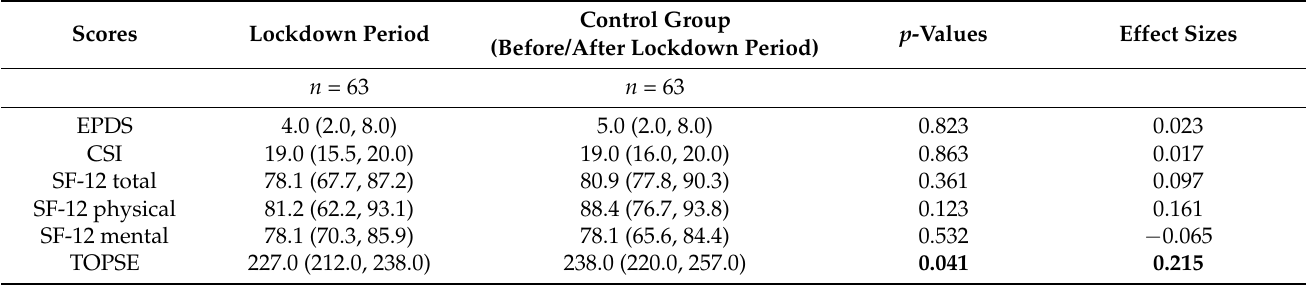
Table 2. Characteristics of standardized evaluation of tendency to depression (EPDS), couple satisfaction (CSI), quality of life (SF-12) and self-efficacy (TOPSE). A p -value of <0.05 is considered significant meaning that parental self-efficacy has been reduced during the lockdown period (marked in bold). Values given as mean (95% CI).